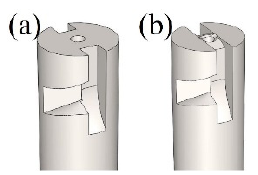
Figure 14. General view of the basic ( a ) and modernized ( b ) plunger of the high-pressure fuel